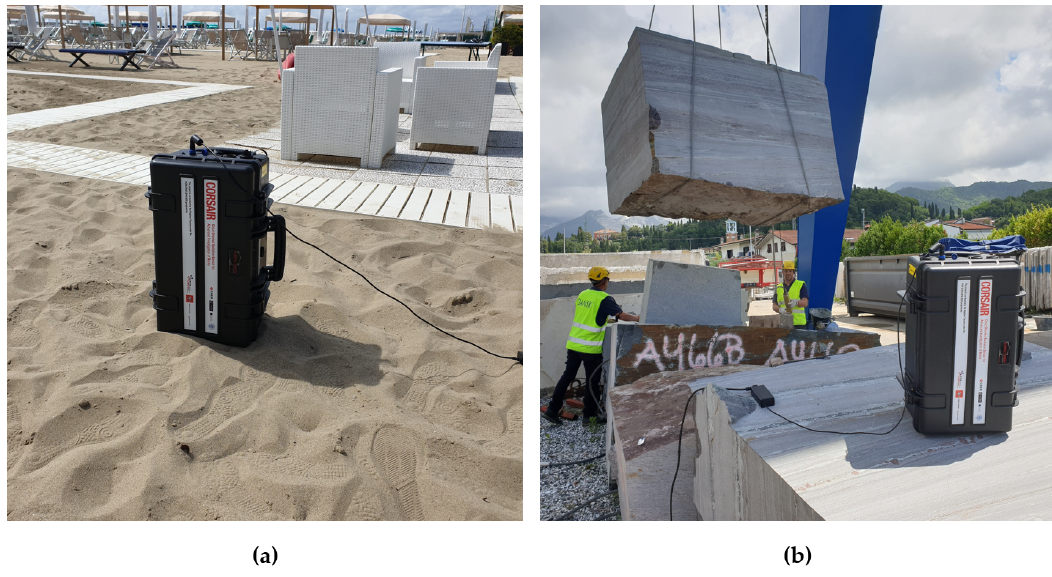
Figure 13. ( a ) Photo of the CORSAIR equipment during the M1 measurement on sand. ( b ) Photo of the equipment performing the M2 measurement on a typical 3 × 3 × 2 m 3 granite